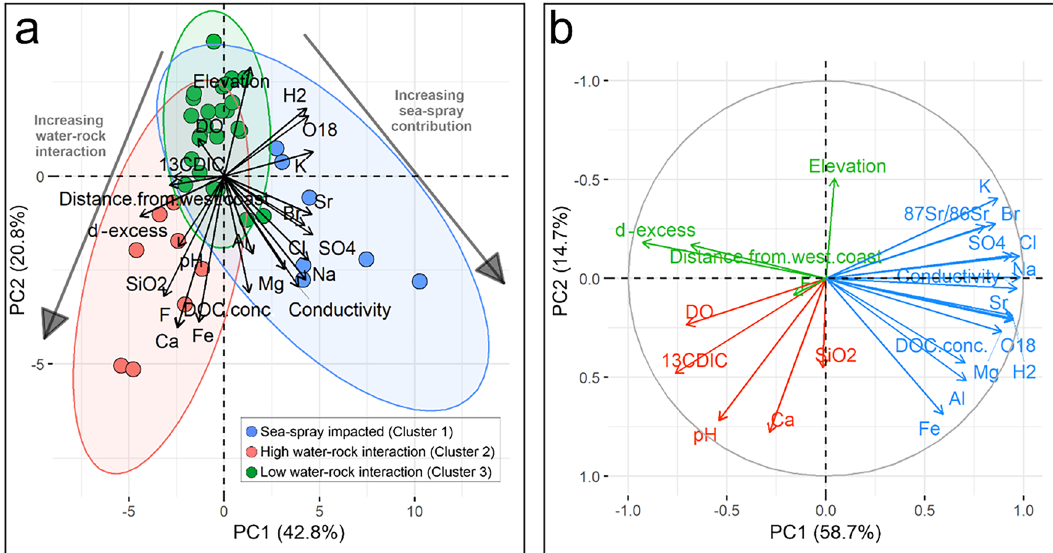
Figure 6. ( a ) Principal Component Analysis (PCA) of Macquarie Island lakes excluding 87 Sr/ 86 Sr. 87 Sr/ 86 Sr results were omitted from this PCA due to the low sample size (n = 10), which would result in the omission of 30 out of 40 lakes in the dataset and a reduction of the statistical power of the PCA. Sample colours represent lake clusters (see Fig. 3). Clusters are interpreted as groups of lakes impacted by sea-spray (Cluster 1 in Fig. 3), and two clusters less impacted by sea-spray, but impacted by high and lower water–rock interactions (Clusters 2 and 3 respectively in Fig. 3). ( b ) PCA of Macquarie Island lakes, including 87 Sr/ 86 Sr (n = 10) results. This biplot shows that the highest 87 Sr/ 86 Sr values in the dataset are associated with sea-spray inputs including SO 4 , Br, Cl, Na and conductivity. In contrast, low 87 Sr/ 86 Sr values are associated with lake waters which have undergone high water– rock interaction and the dissolution of secondary carbonates resulting in high 13 C DIC , pH, Ca and HCO 3 . Note: The Component 2 (PC2) axis in ( b ) is flipped for easy comparison to (a).